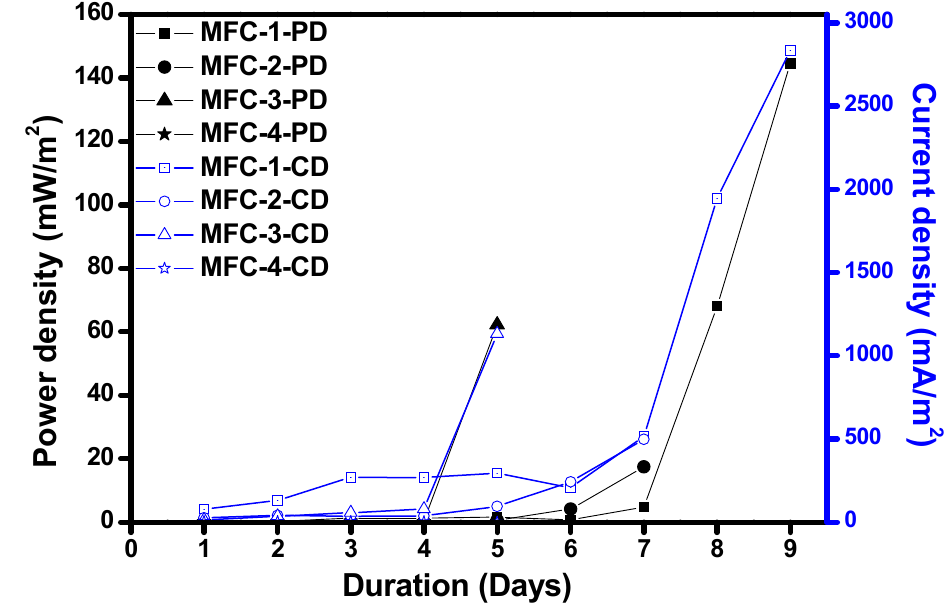
Figure 8. Duration vs. current density and power density for all the MFCs.